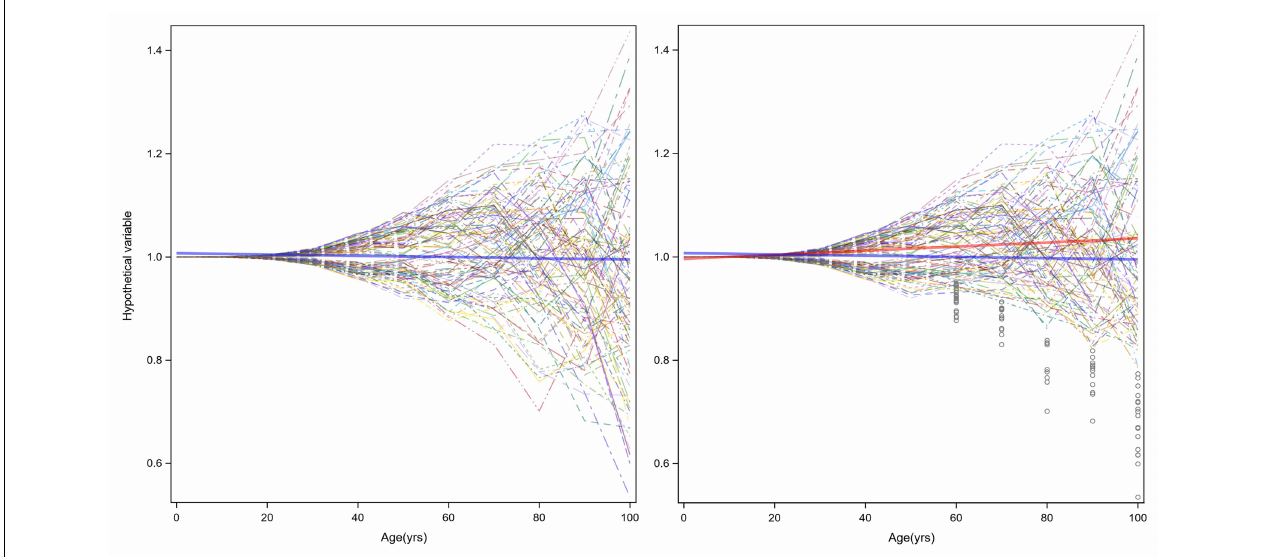
FIGURE 6 | Age-related increase of heterogeneity of traits associated with health status may cause changes in average levels of that trait with aging. In the left panel, a hypothetical variable is perfectly controlled over the first years of life, but slowly and progressively, the homeostatic control becomes less effective, and variability increases symmetrically around the average (blue line). However, if the hypothetical variable is a “protective factor,” such as HDL-Cholesterol, and a person with low values has higher risk of cardiovascular disease, the consequent unobserved values show grey circles in the right panel the longitudinal distribution of age-trajectories truncated and asymmetrical. A linear regression with age (red) shows an increasing